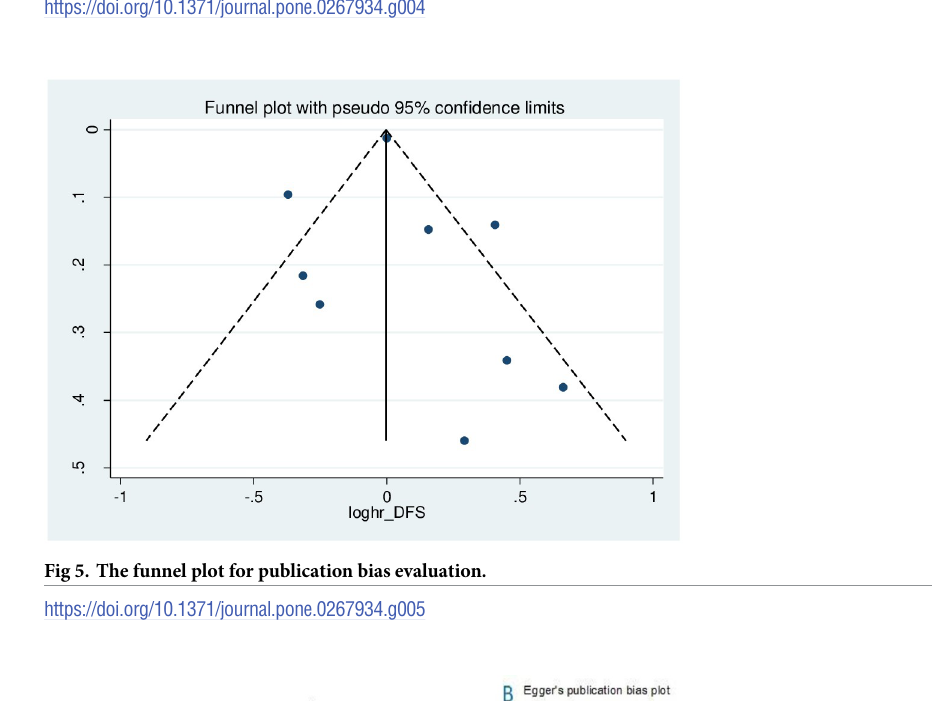
Fig 4. Galbraith plot for indicating the sources of heterogeneity among meta-analysis results.